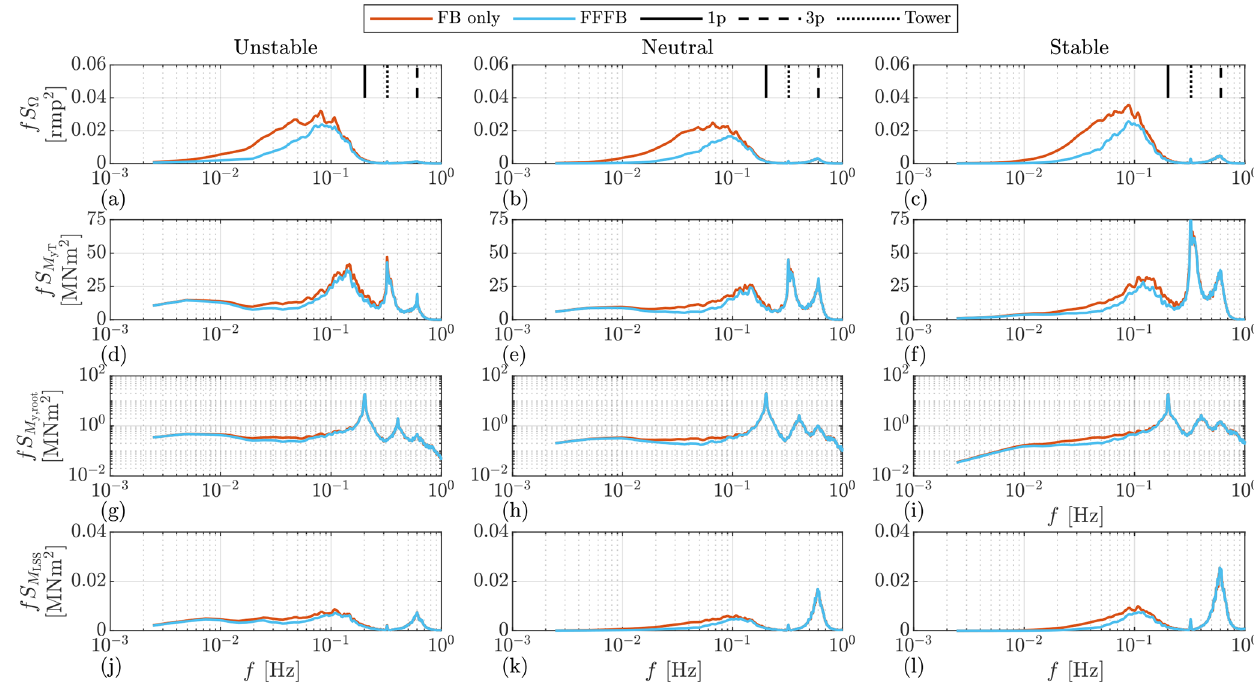
Figure 11. The auto-spectra estimated from OpenFAST output time series. The simulation results are obtained using the Mann model. The mean wind speed is 16ms − 1 . Note that the y axis of the blade root bending moment is set to logarithmic for better readability.